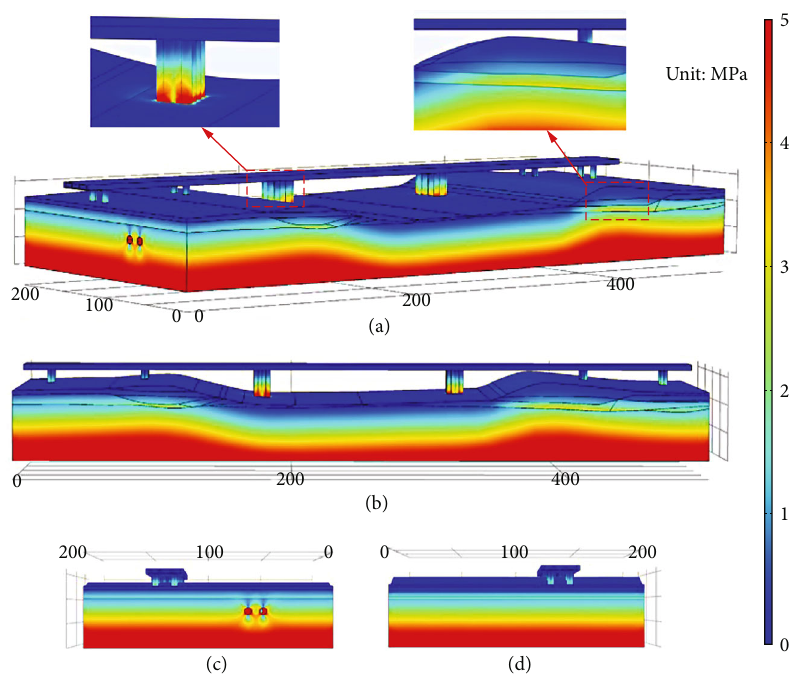
Figure 8: Model initial state stress distribution diagram. (a) Initial state stress distribution diagram. (b) Cross-sectional view of model stress distribution. (c) Longitudinal section of model stress distribution. (d) Longitudinal section of model stress